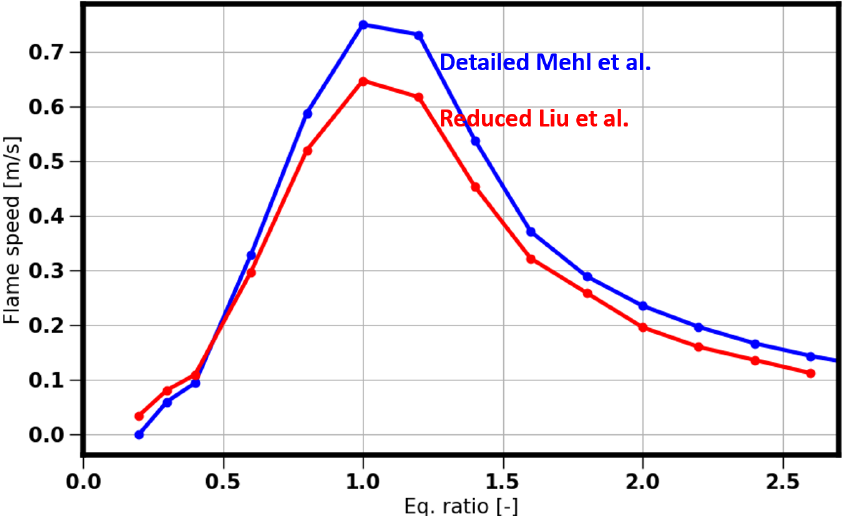
Figure 3. Laminar 1D premixed flame speed comparison between the reduced Liu [32] mechanism and the detailed Mehl [33] mechanism. The pressure is 36.8